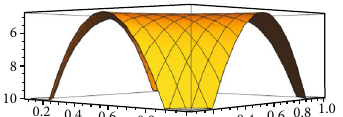
Figure 5: The area integrand function for the biquadratic Bézier surface with shifted knots for η = 0 : 2 and λ = 0 : 2 .